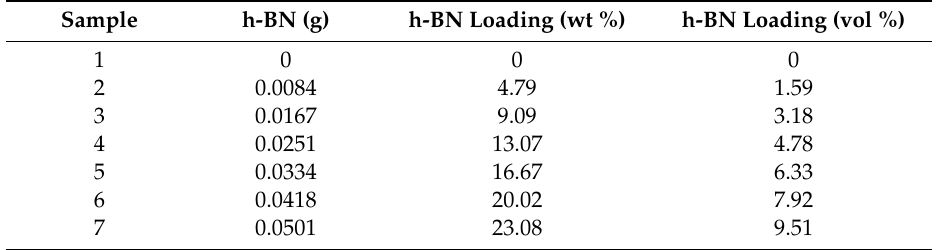
Table 1. Ratio of h-BN of the composite films (the CNF dry weight of all samples was 0.167 g). Sample h-BN (g) h-BN Loading (wt %) h-BN Loading (vol %)